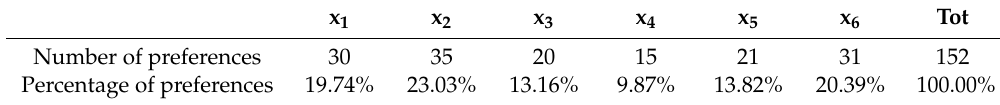
Table 4. Preferences expressed by tourists about the characteristics that improved most